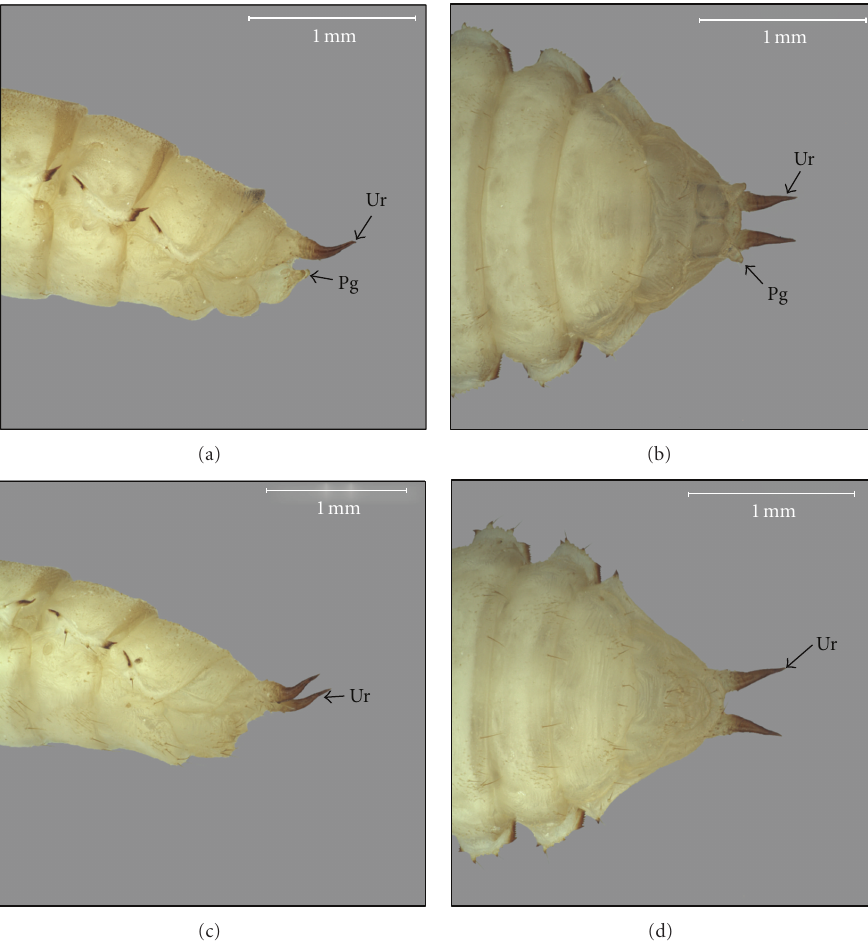
Figure 2: External posterior characteristics for determining sex of A. diaperinus pupae: female with urogomphus and prominent pygopods ((a) lateral view and (b) ventral view) and male with urogomphus, lacking prominent pygopods ((c) lateral view and (d) ventral view). Pg, pygopods; Ur, urogomphus.